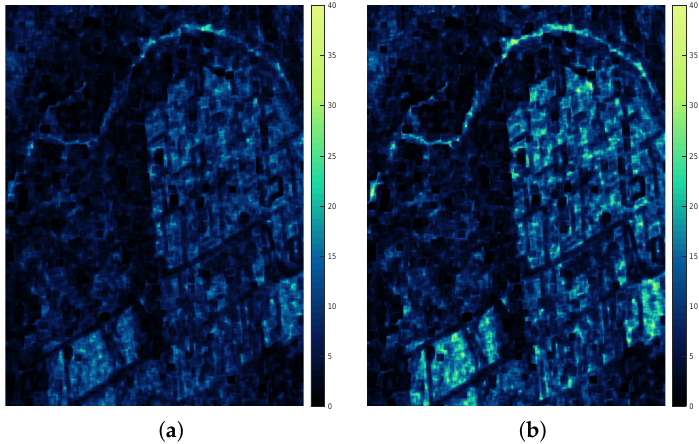
Figure 10. Estimated ENL by means of an 11